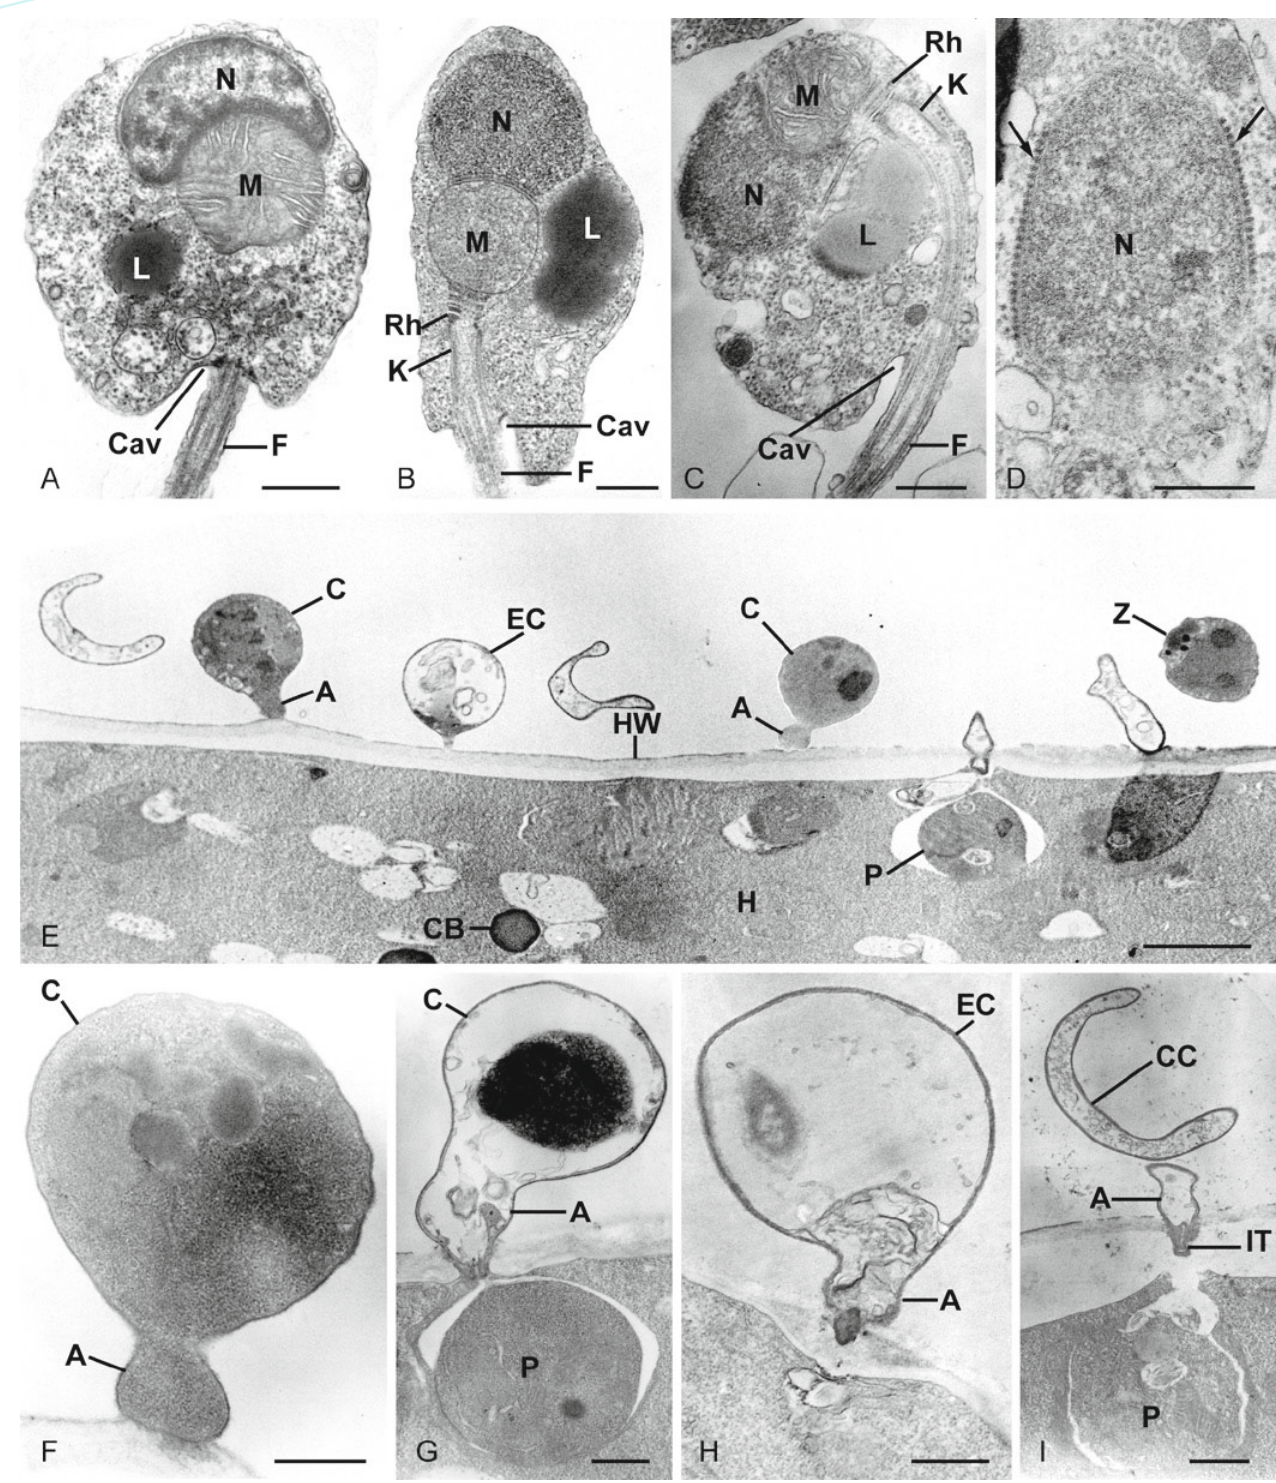
Fig. 2. Transmission electron microscopic images of Rozella (cid:2)"(cid:4)(cid:4)(cid:7)(cid:18)(cid:4)(cid:10)(cid:13)(cid:7)(cid:2)(cid:9)(cid:17)(cid:21)(cid:2)(cid:11)(cid:17)(cid:26)(cid:13)(cid:19)(cid:8)(cid:11)(cid:4)(cid:17)(cid:28)(cid:2) A. R. allomycetis [strain CSF 55; Powell et al . 2017]. B. R.multimorpha [strain JEL 883; Letcher et al . 2018]. C–D. R. rhizoclosmatii [strain JEL 863; Letcher et al . 2017]. D. A lattice of perpendicular rods (arrows) about the nucleus. E–I. R. allomycetis (cid:2)(cid:147)(cid:7)(cid:8)(cid:10)(cid:9)(cid:11)(cid:17)(cid:2)R(cid:134)(cid:2)(cid:148)/X(cid:30)(cid:2)(cid:133)(cid:4)(cid:15)(cid:13)(cid:23)(cid:23)(cid:2)(cid:9)(cid:17)(cid:21)(cid:2)^(cid:13)(cid:8)(cid:19)(cid:14)(cid:13)(cid:10)(cid:29)(cid:2)(cid:5)(cid:17)(cid:18)(cid:5)(cid:12)(cid:23)(cid:28)G(cid:2)(cid:18)(cid:9)(cid:10)(cid:9)(cid:7)(cid:11)(cid:8)(cid:11)"(cid:11)(cid:17)(cid:25)(cid:2) Allomyces macrogynus . E. Early stages of infection. F. (cid:2)V(cid:17)(cid:19)(cid:22)(cid:7)(cid:8)(cid:13)(cid:21)(cid:2)"(cid:4)(cid:4)(cid:7)(cid:18)(cid:4)(cid:10)(cid:13)(cid:28)(cid:2) G. (cid:2)(cid:130)(cid:4)(cid:4)(cid:7)(cid:18)(cid:4)(cid:10)(cid:13)(cid:2)(cid:19)(cid:22)(cid:7)(cid:8)(cid:2)(cid:9)(cid:17)(cid:21)(cid:2)(cid:13)(cid:9)(cid:10)(cid:23)(cid:22)(cid:2)(cid:11)(cid:17)(cid:26)(cid:13)(cid:19)(cid:8)(cid:11)(cid:4)(cid:17)(cid:28)(cid:2) H. (cid:2)V(cid:6)(cid:18)(cid:8)(cid:22)(cid:2)"(cid:4)(cid:4)(cid:7)(cid:18)(cid:4)(cid:10)(cid:13)(cid:2)(cid:19)(cid:22)(cid:7)(cid:8)(cid:28)(cid:2) I. (cid:2)B(cid:4)(cid:23)(cid:23)(cid:9)(cid:18)(cid:7)(cid:13)(cid:21)(cid:2)"(cid:4)(cid:4)(cid:7)(cid:18)(cid:4)(cid:10)(cid:13)(cid:2)(cid:19)(cid:22)(cid:7)(cid:8)(cid:2)(cid:9)(cid:17)(cid:21)(cid:2)(cid:13)(cid:9)(cid:10)(cid:23)(cid:22)(cid:2)